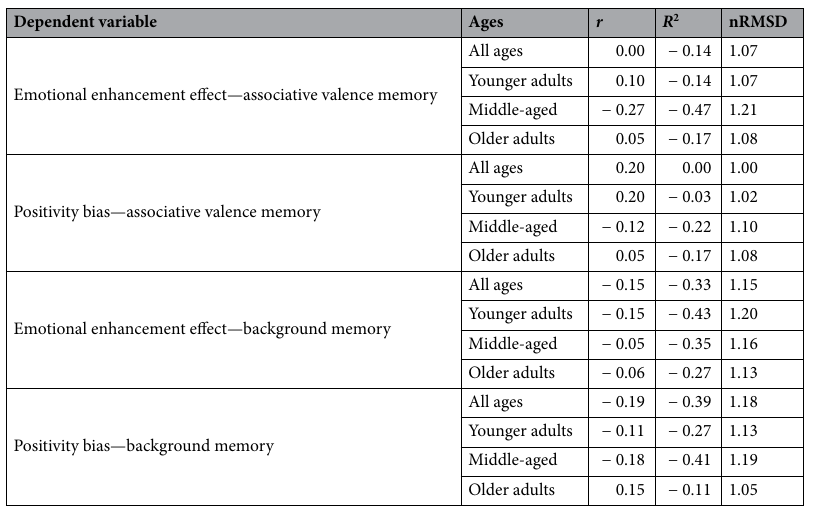
Table 5. Model prediction results for other memory